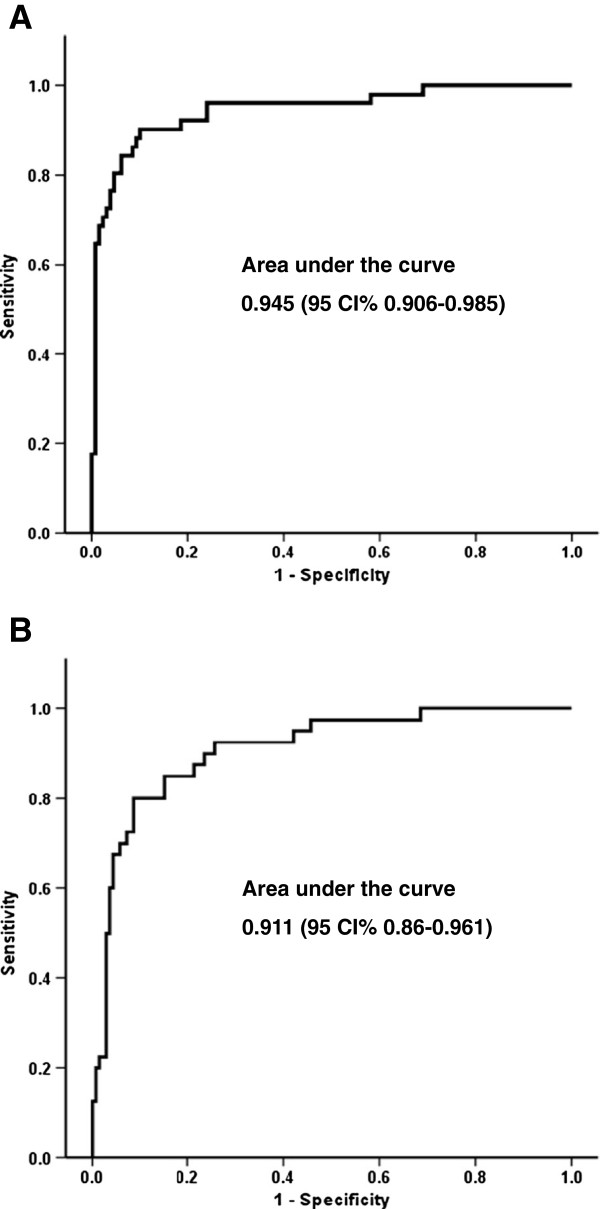
Correlation between CAE levels and response. A. ROC curve for CEA levels and overall response. B. ROC curve for CEA levels and progressive disease.